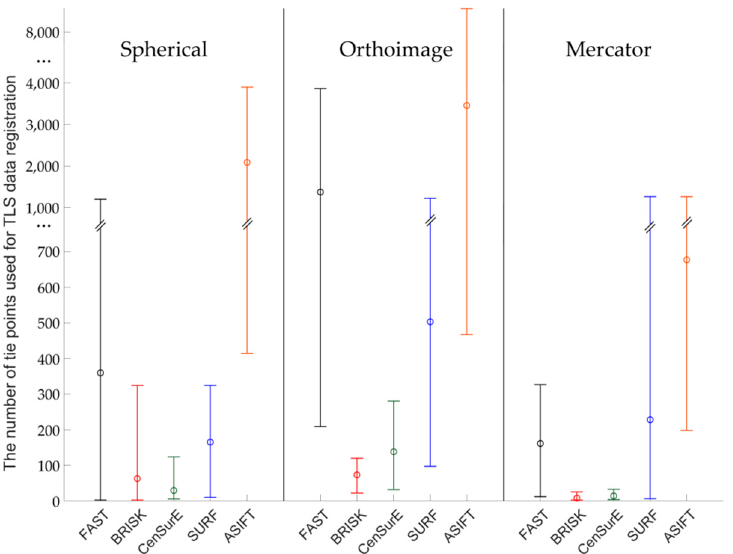
Figure 8. Diagram of the mean (circles), maximum, and minimum number of correctly detected and matched key points using blob (ASIFT, SURF, and CenSurE) and point (FAST and BRISK) detectors for rasters in the spherical projection, orthoimages, and the Mercator projection; Test Site I. The mean, maximum and minimum percentage values of correctly detected and matched key